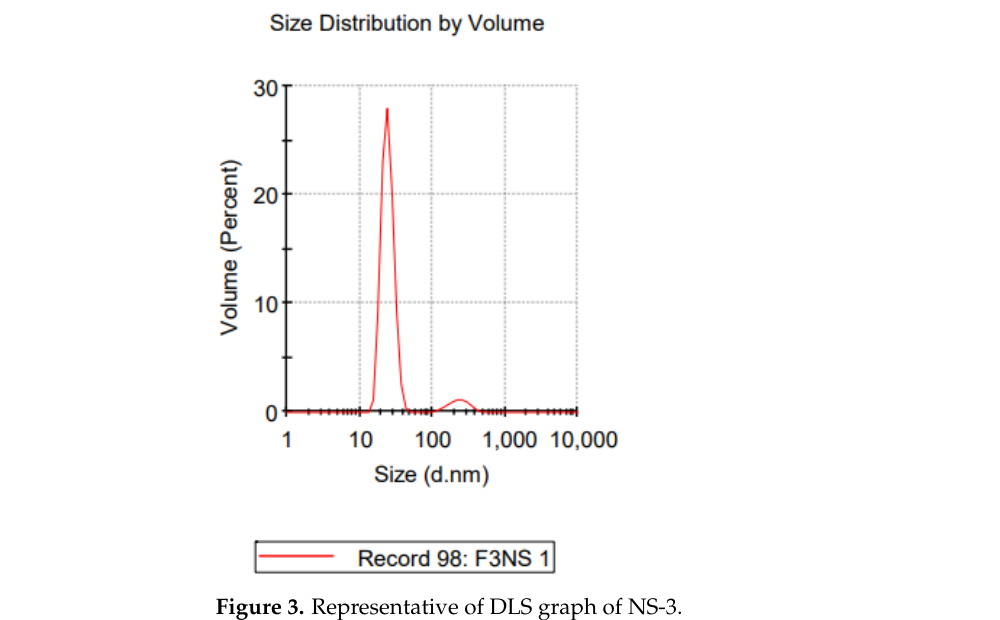
Table 3. Formulations of Co-grinded Ketoprofen.